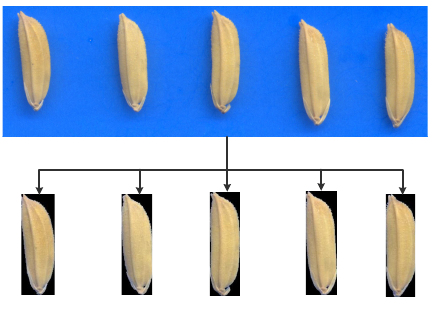
Figure 5. Rice image pre-processing.